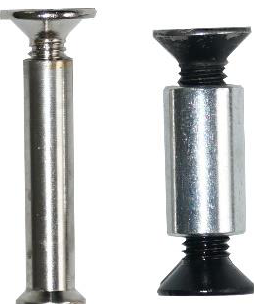
Figure 3. Used screws: ( left ) sleeve bolt (sb) and ( right ) a sleeve with screws from both sides (sl).